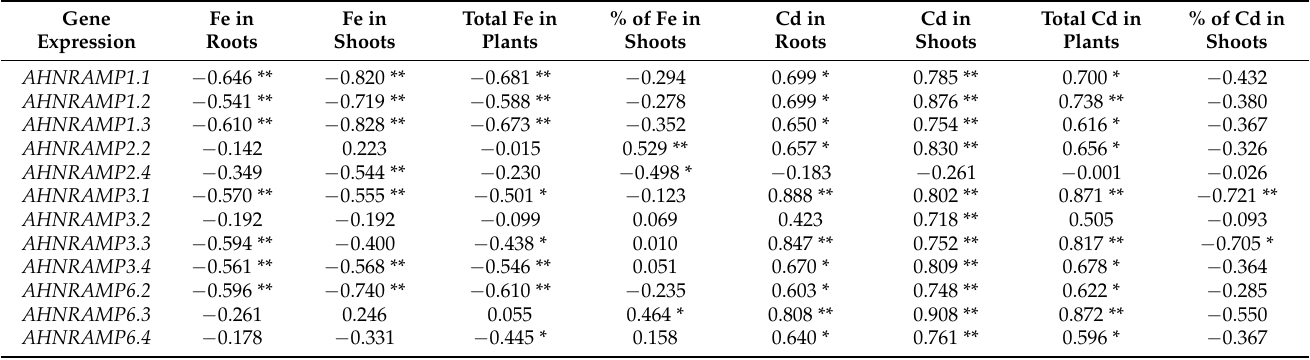
Table 3. Correlations Fe/Cd accumulation and the expression of AhNRAMP genes in the roots of two peanut cultivars ( n = 24 and 12 for Fe and Cd accumulation,